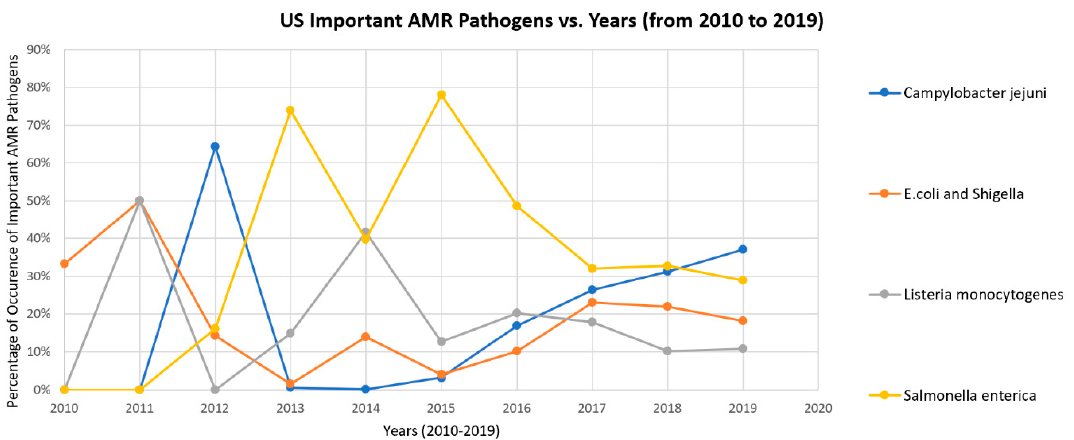
Figure 4. Frequency of highly-occurring pathogens over the years 2010–2019 in the US.